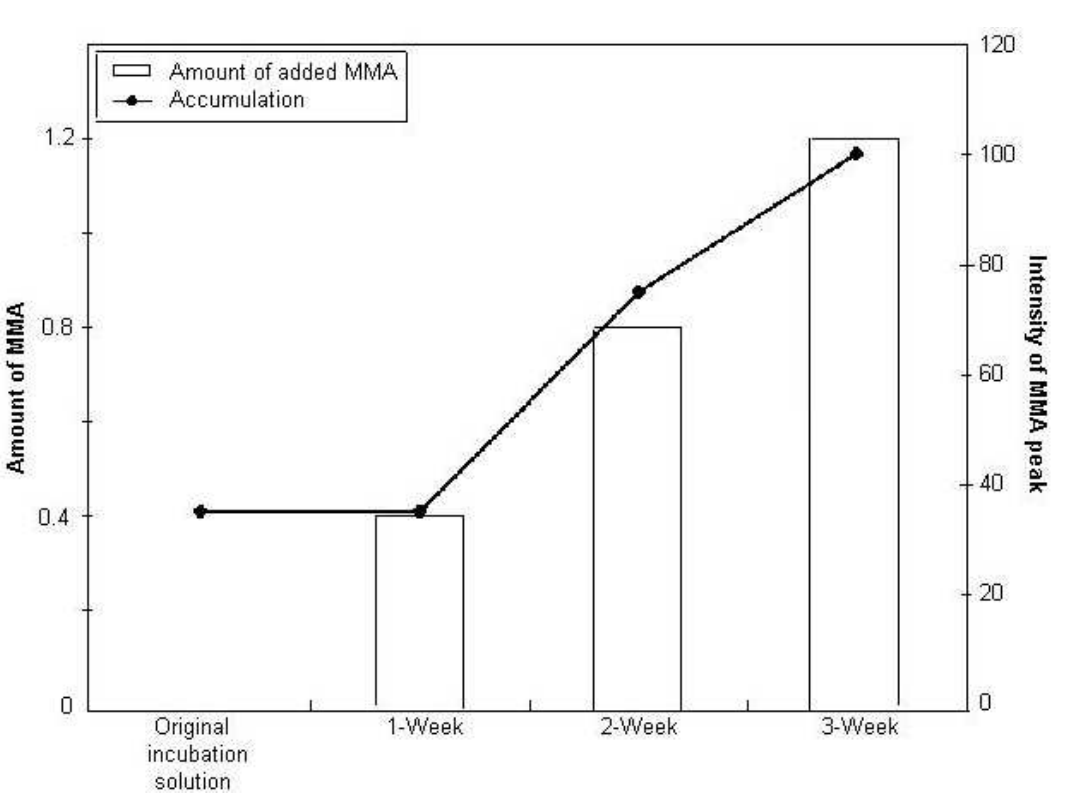
Fig. 3 Graph of CHMA accumulation after different time